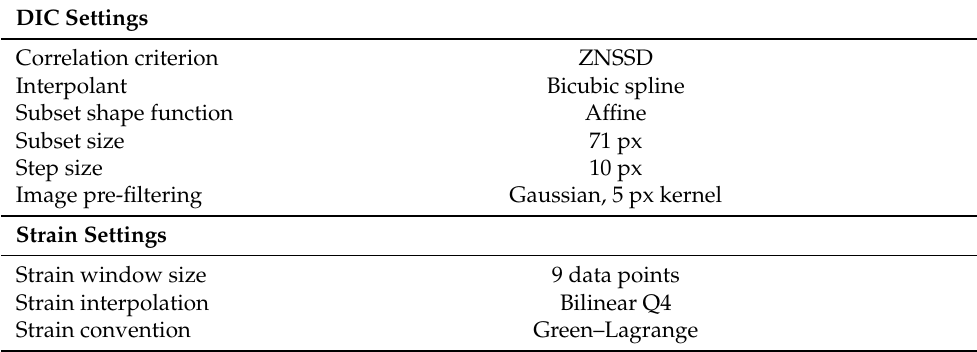
Table 5. DIC and strain settings selected in the full-field